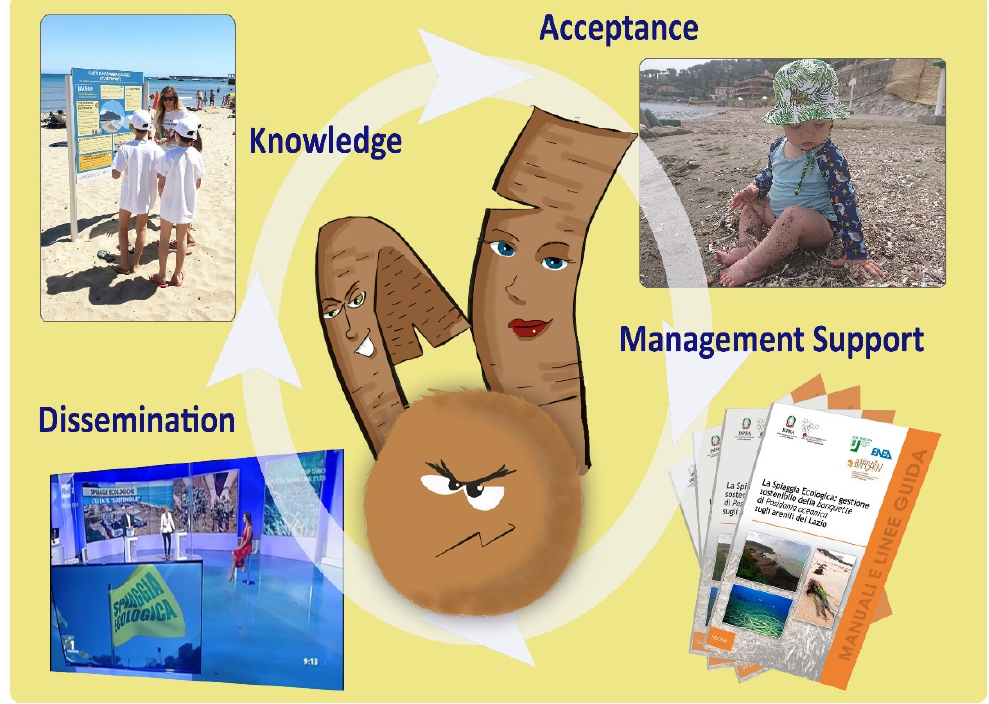
Figure 3. The virtuous circle of the Ecological Beach model.